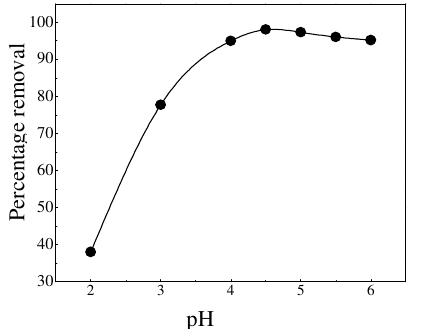
Figure 1. Effect of pH on the removal of Pb(II) ions by CSC (Initial Concentration- 10 mg L -1 ).